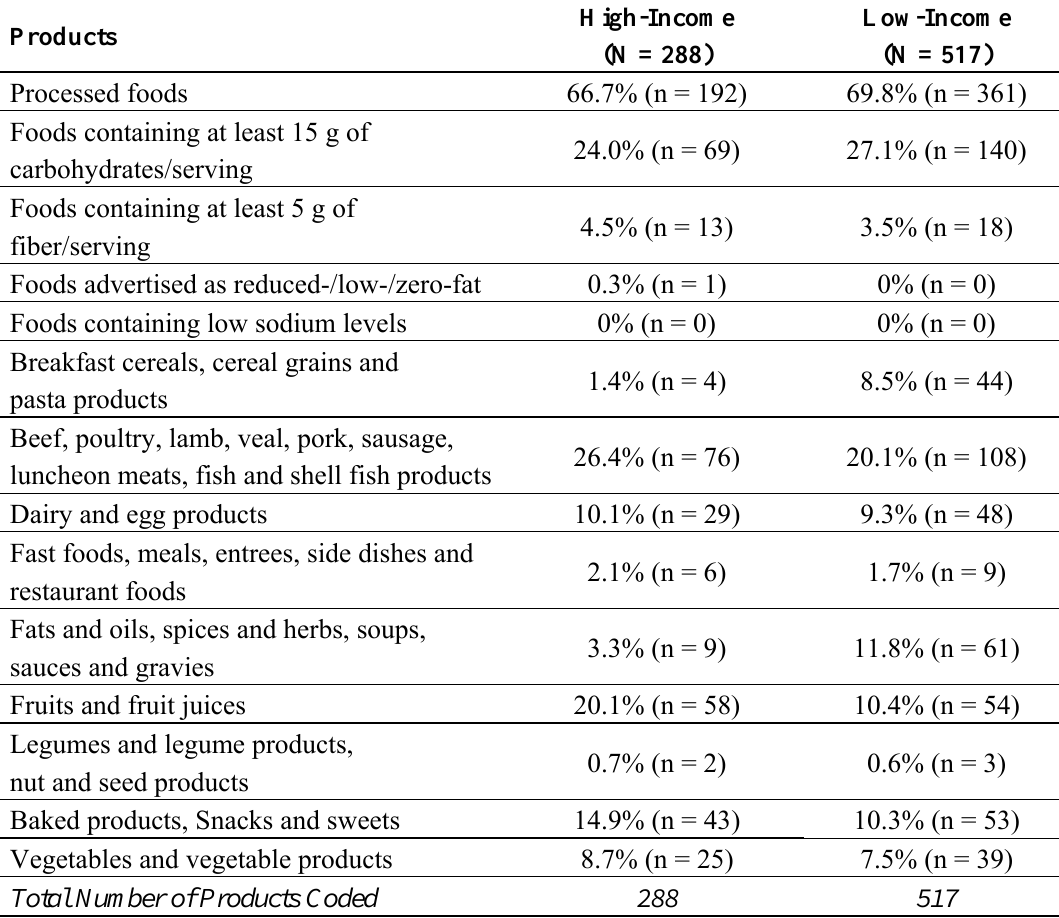
Table 1. Frequency distribution of featured circular products: low- versus